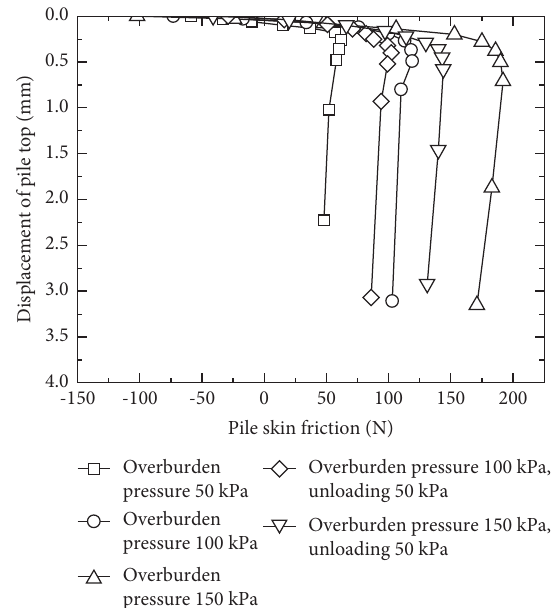
Figure 15: Pile skin friction versus displacement of pile top.